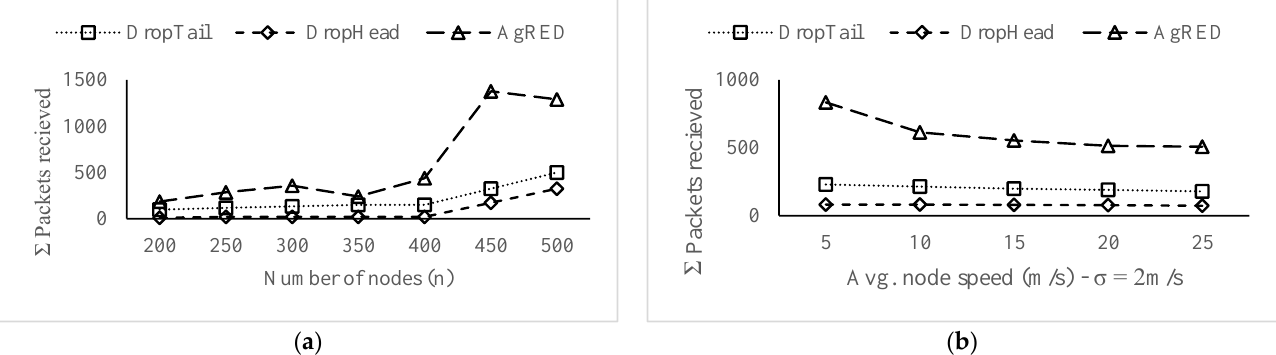
Figure 16. Sum of data packets received (UDP) for Drop-tail, Drop-head and AgRED with ( a ) varying number of nodes and ( b ) varying speed.